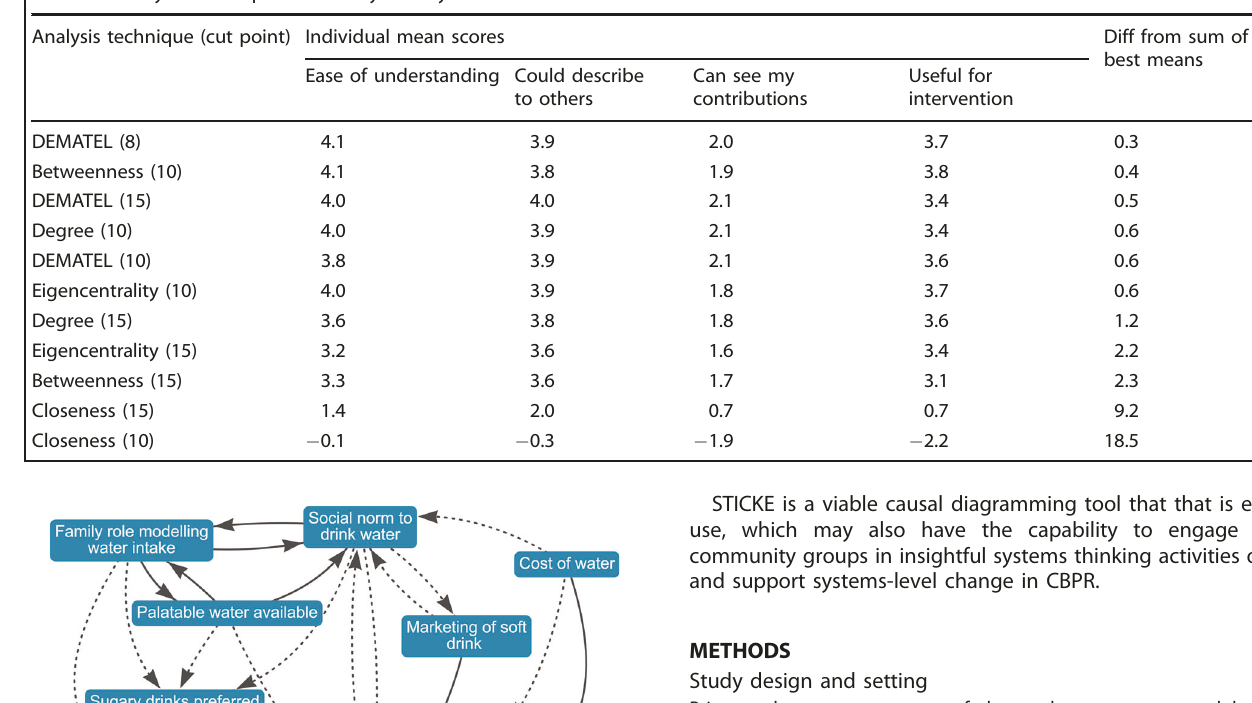
Table 1. Analysis techniques ranked by validity items and deviation-from-best-mean score.